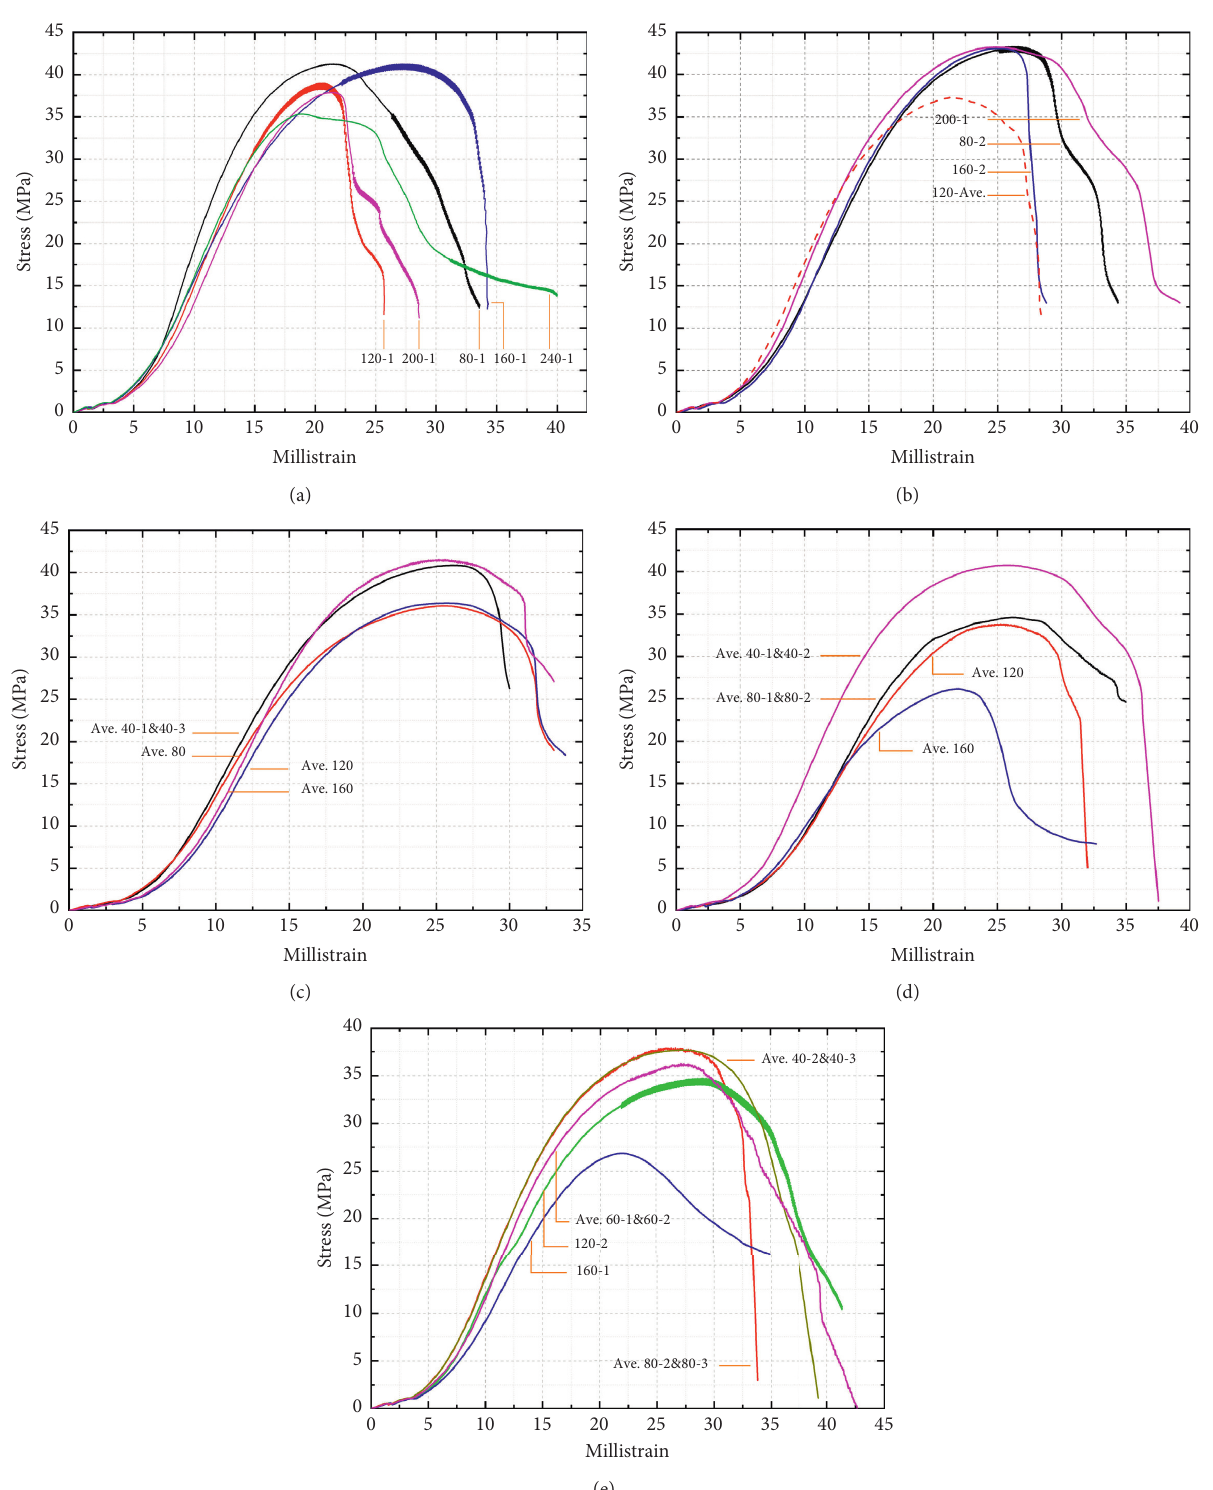
Figure 4: Strain-stress relationships for the specimens mixed with particles of (a) 0.6mm, (b) 1.0 mm, (c) 1.4mm, (d) 1.8 mm, and (e) Table 1 should have been equal to 1 at the very beginning, and the reason for the inconsistency was interpreted in Section 2.1. Hence, the ratio should be adjusted accordingly.